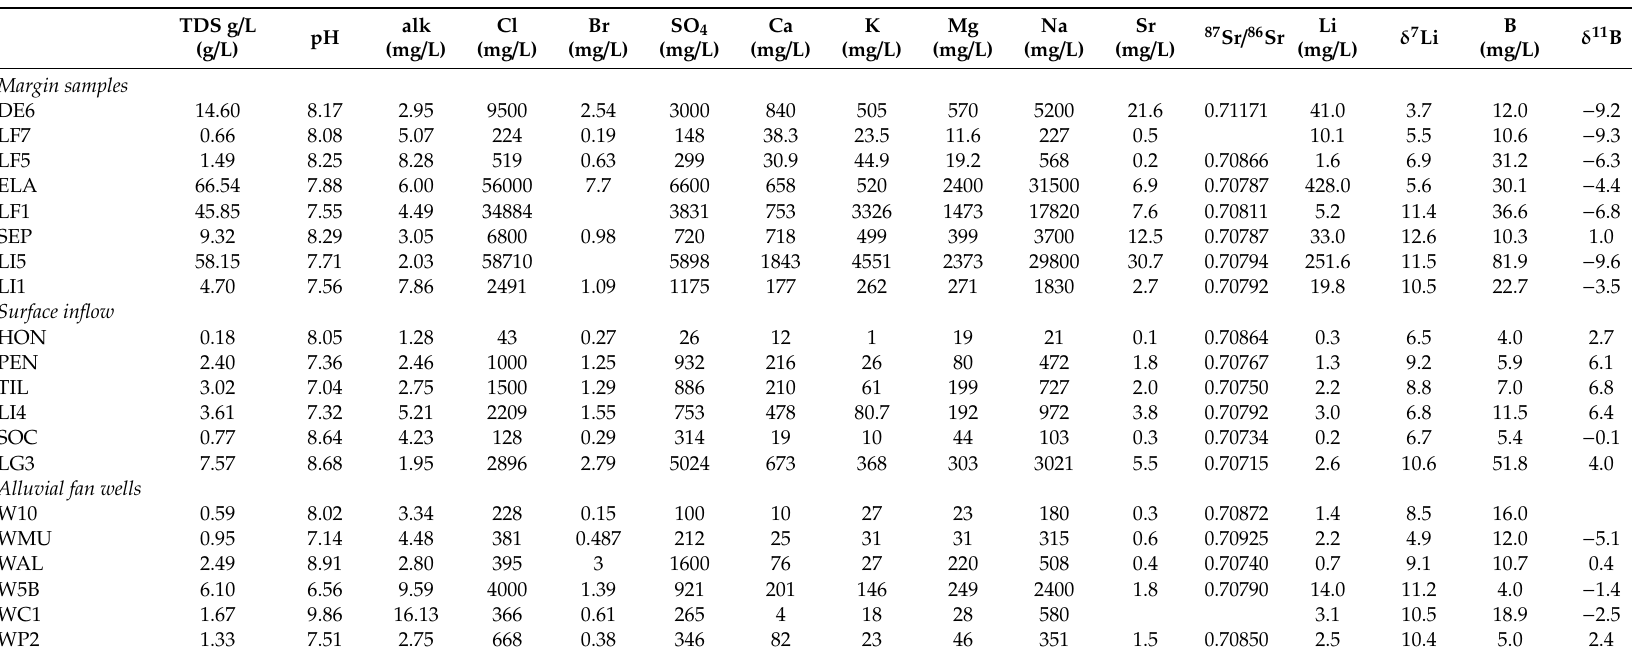
Table 1. Field measurements, concentration and isotopic data for water samples from the southern part of the Salar de